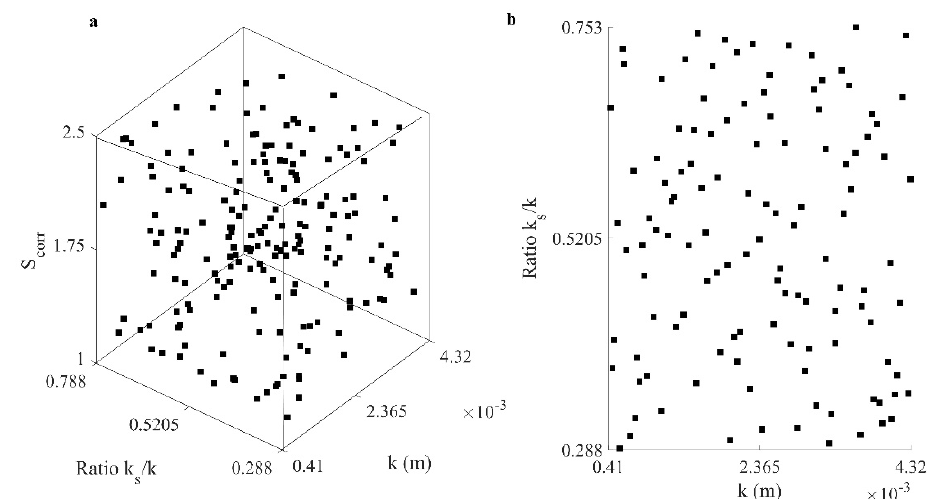
Figure 5. Sample points for ( a ) the HAX model and ( b ) the 2PP model obtained by Latin Hypercube Sampling.